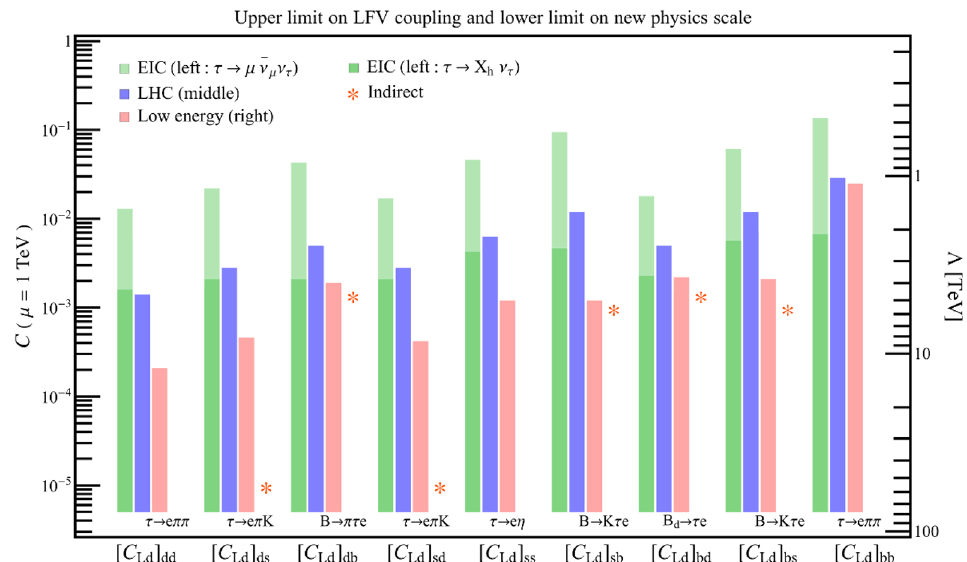
Figure 13 . Upper limit on C Ld (leftmost axis) and lower limit on new physics scale Λ (rightmost axis) from the EIC (left), LHC (middle) and low-energy observables (right). The symbol “ ∗ ” indicates indirect bounds discussed in section 8. For the EIC expected sensitivity, the light green bar corresponds to the result in table 7, while the dark green one represents the case in hadronic tau decay mode assuming (cid:15) = 1 with n = 0 in tables 3–5. n b b